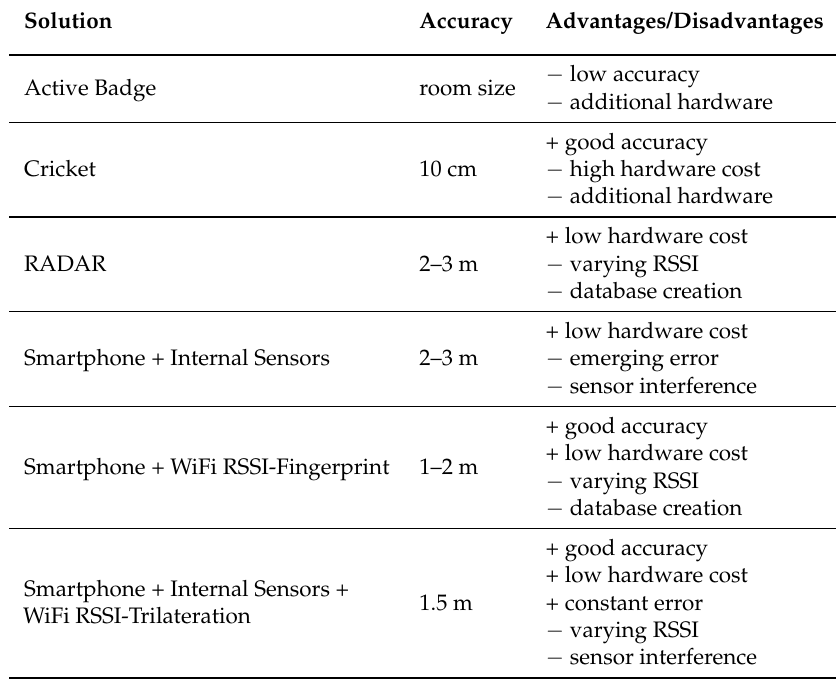
Table 2. Accuracy of different approaches